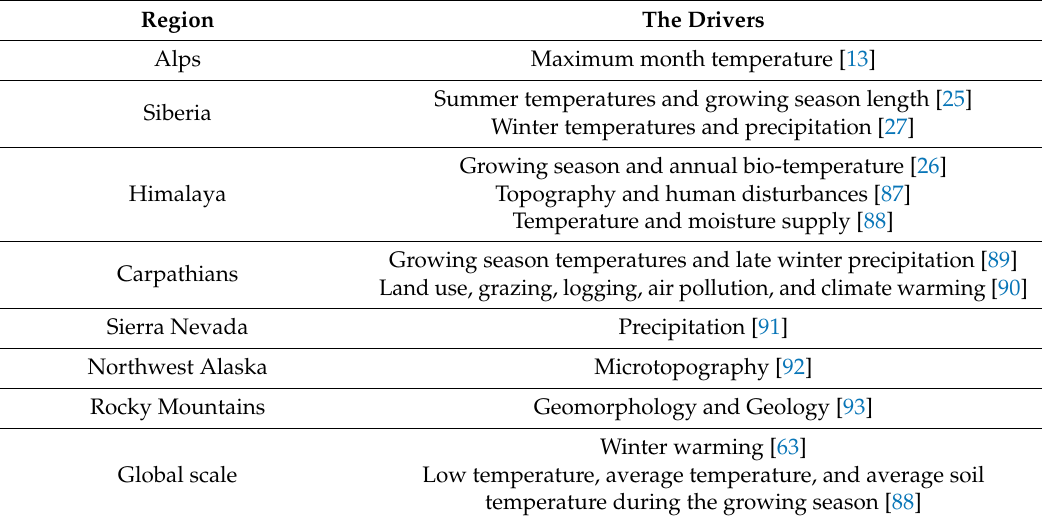
Table 3. Alpine timberline driving factors in di ff erent